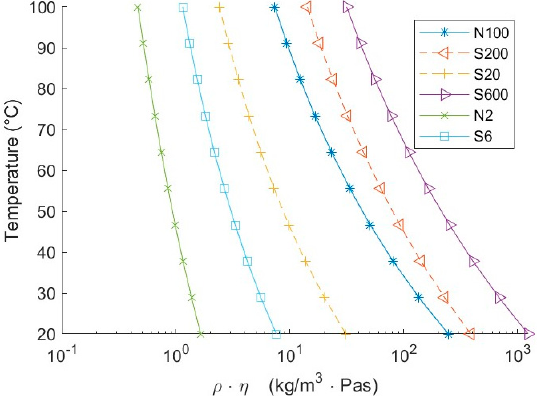
Figure 2. Product of viscosity and density ( ρη ) of fluids as a function of temperature. Solid lines are fluids used to create a baseline, and dashed lines are fluids used for validation.